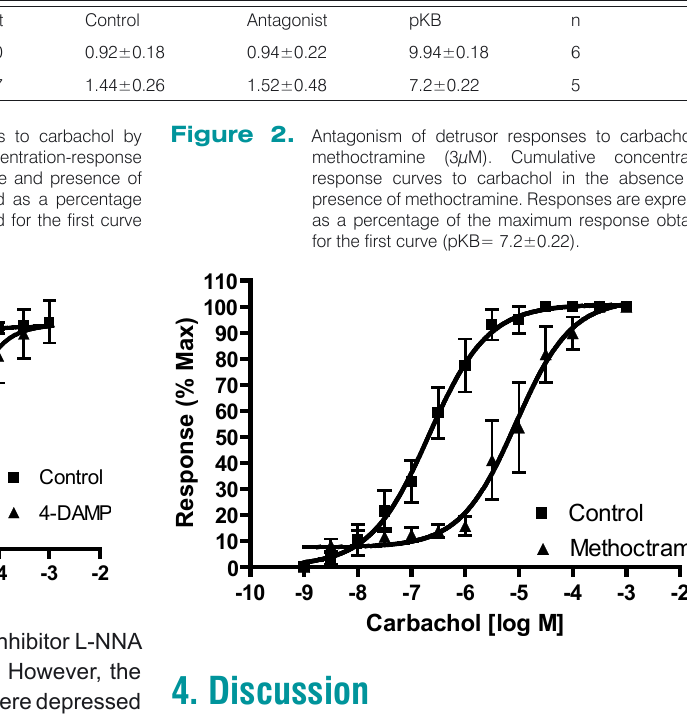
Table 2. The mean maximum responses, pEC and pKB values of the mouse urinary bladders in response to carbachol in the presence of 50 muscarinic antagonists 4-DAMP and Mean maximum response (g) pEC 50